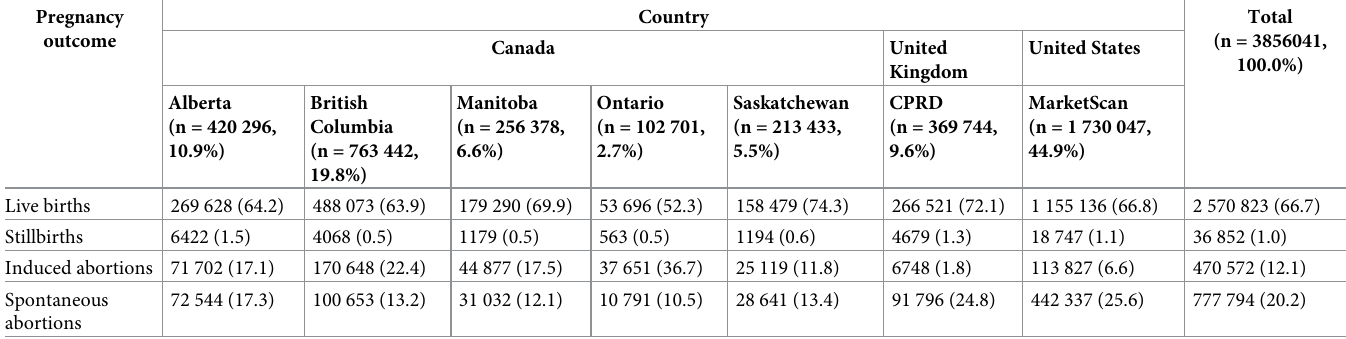
Table 1. Pregnancies in included databases, by pregnancy outcome. Pregnancy